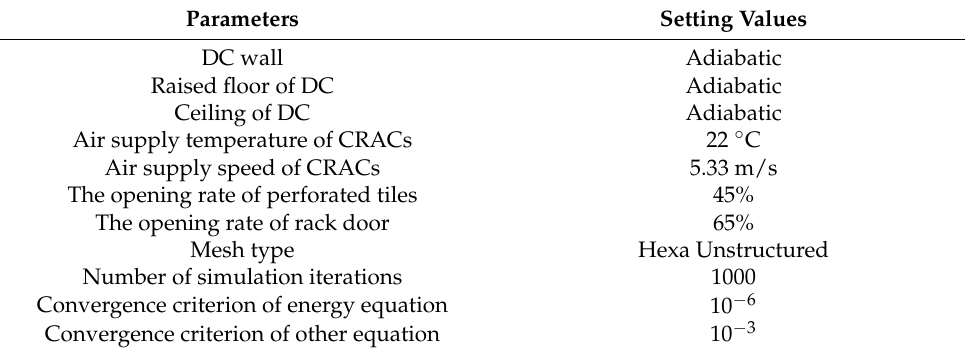
Table 2. The summary of simulated boundary conditions and related parameter